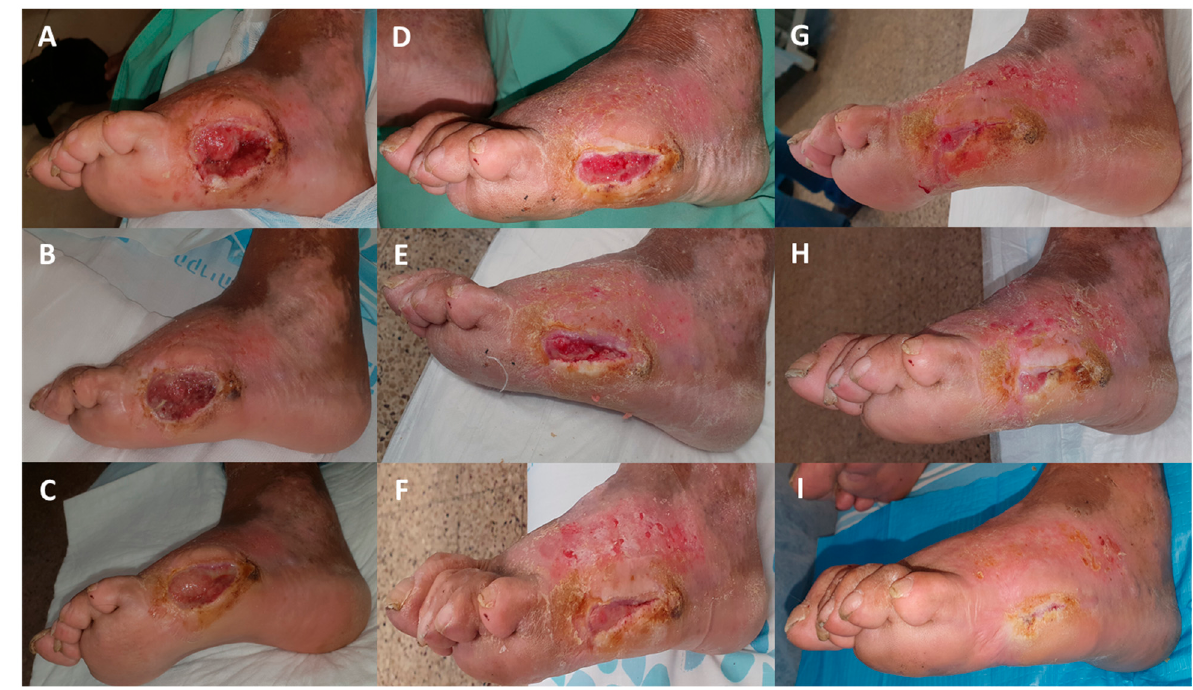
Figure 10. Enhanced wound healing after switching to COD treatment (Case Report 8). Sixty-year-old man with NIDDM underwent resection of the fifth metatarsal of the left foot due to chronic ulcer and osteomyelitis. Due to insufficient wound healing the patient underwent successful percutaneous angioplasty of the left leg. ( A ) One week after angioplasty. The patient was treated with standard dressings and VAC without significant progress. ( B ) Seven days later (14 days post angiography), no progress is observed. The wound measured 47 mm × 23 mm. Treatment with absorbent dressing was applied. ( C ) Six days later the wound size remained steady, measuring 46 mm × 23 mm (2.5% area reduction/week). ( D ) Nine days later, this time treatment was with COD. Wound size has been reduced to 43 mm × 13.5 mm (35% area reduction/week) with deep red granulation tissue. ( E–I ) Serial photos over additional two months of COD until final wound closure.